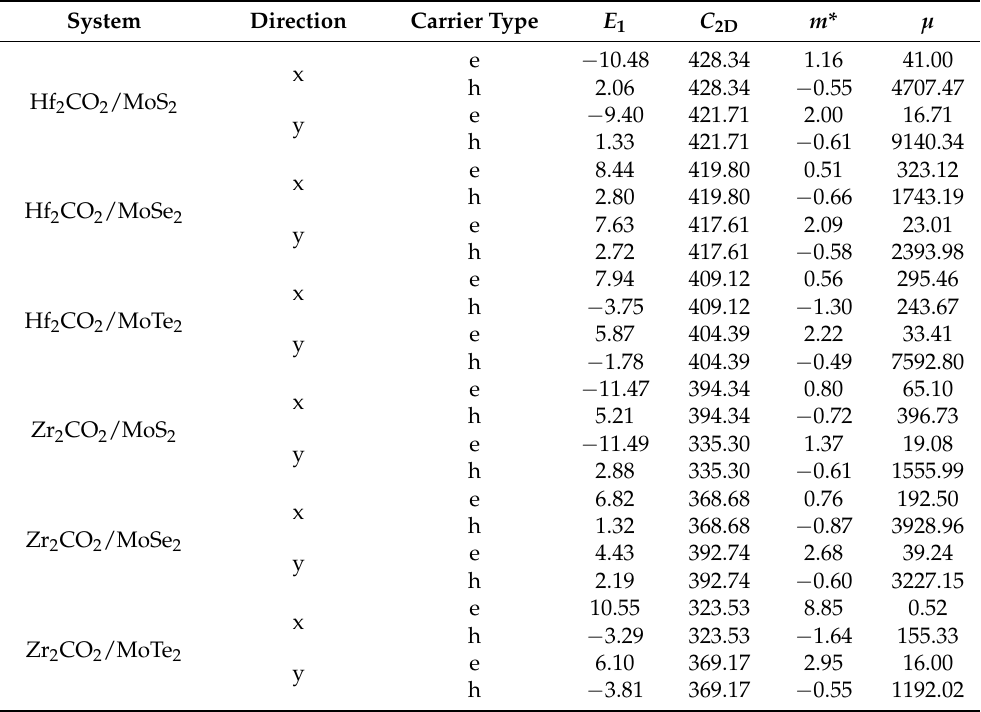
Table 1. The effective mass m * (m 0 ), deformation potentials E 1 (eV), elastic moduli C 2D (N/m),